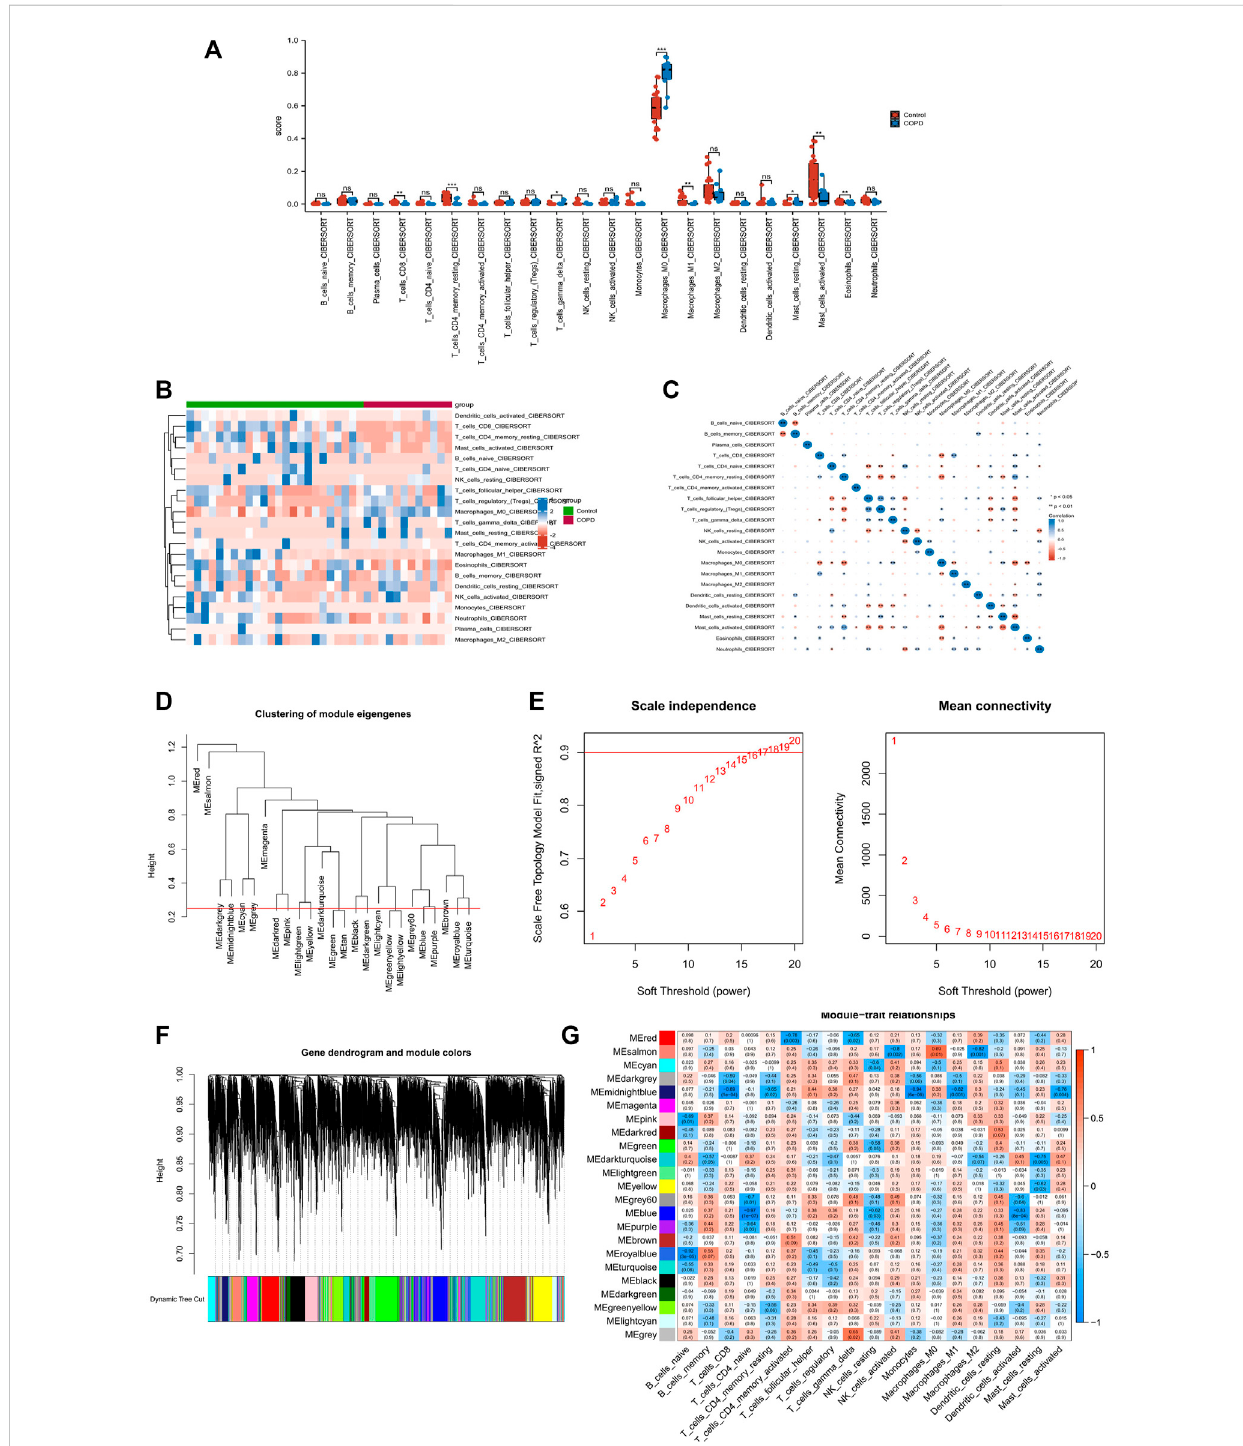
FIGURE 1 Immune in fi ltration analysis and identi fi cation of macrophage-related modular genes. (A) The CIBERSORT algorithm was used to analyze the content of immune cells. (B) A holistic view of the distribution of immune cells between different tissues. (C) Correlation analysis was performed on all immune cells in the CIBERSORT algorithm. (D) Correlation diagram between modules obtained by clustering according to inter-gene expression levels. (E) Screening for suitable softthresholds and scale-free networkvalidation.The softthresholdisselected as 16. (F) Theclusterdendrogramwith the gene modules and module merging. (G) The correlation between gene modules and immune cell